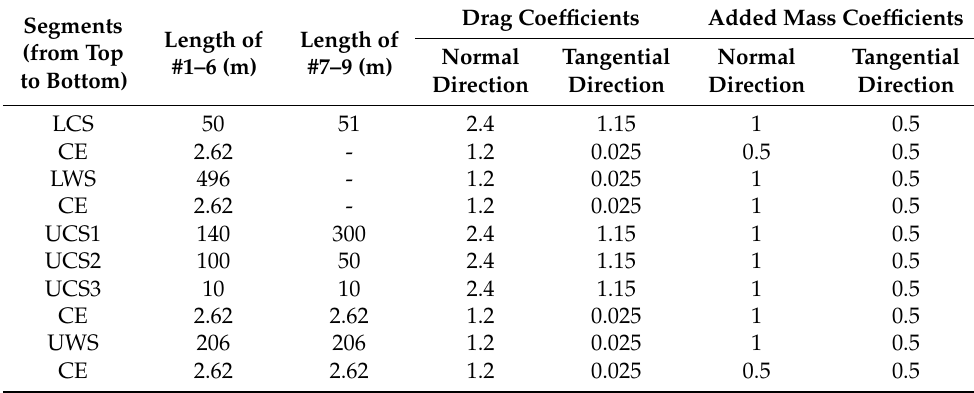
Figure 4. Mooring system layout. Table 2. Mooring line components.